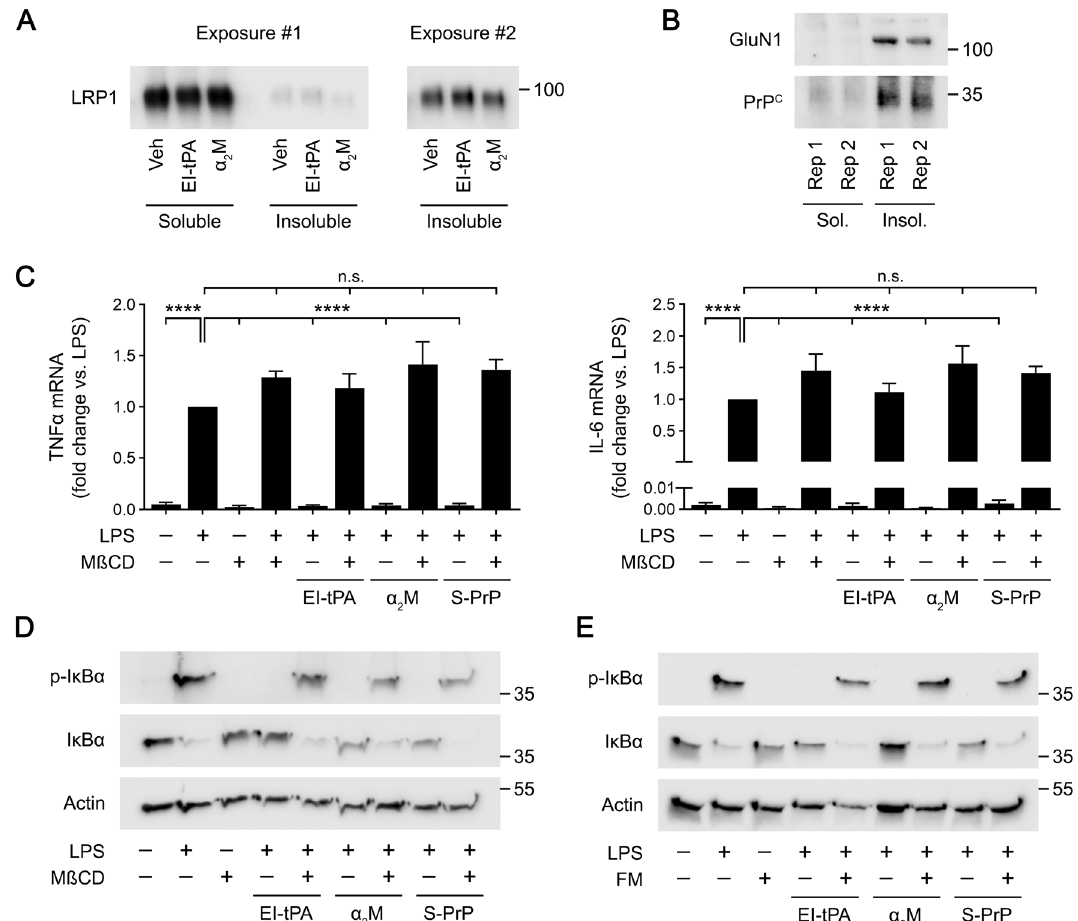
Figure 1. Lipid rafts are required for the anti-inflammatory activity of EI-tPA, α 2 M and S-PrP in BMDMs. ( A ) BMDMs isolated from WT mice were treated with EI-tPA (10 nM), α 2 M (10 nM) or vehicle for 1 h. Triton X-100 extracts were prepared in which cell-surface proteins were biotinylated. The biotinylated detergent- soluble and -insoluble fractions were compared by immunoblot analysis to detect LRP1. A higher exposure of the detergent-insoluble fraction is shown (Exposure #2). (B) Triton X-100 extracts from BMDMs isolated from WT mice were prepared in which cell-surface proteins were biotinylated. The biotinylated detergent-soluble and -insoluble fractions were compared by immunoblot analysis to detect GluN1 and PrP C . Two replicates (Rep 1 and 2) of each condition are shown. (C) BMDMs were pretreated with MβCD (1.0 mM), or vehicle for 30 min and then treated with LPS (0.1 µg/ml) and EI-tPA (10 nM), α 2 M (10 nM) or S-PrP (40 nM) for 6 h. RT-qPCR was performed to compare mRNA levels for TNFα and IL-6 (n = 4–6). Data are expressed as the mean ± SEM (One-way ANOVA; **** P < 0.0001, n.s.: not statistically significant). (D) BMDMs were pretreated with